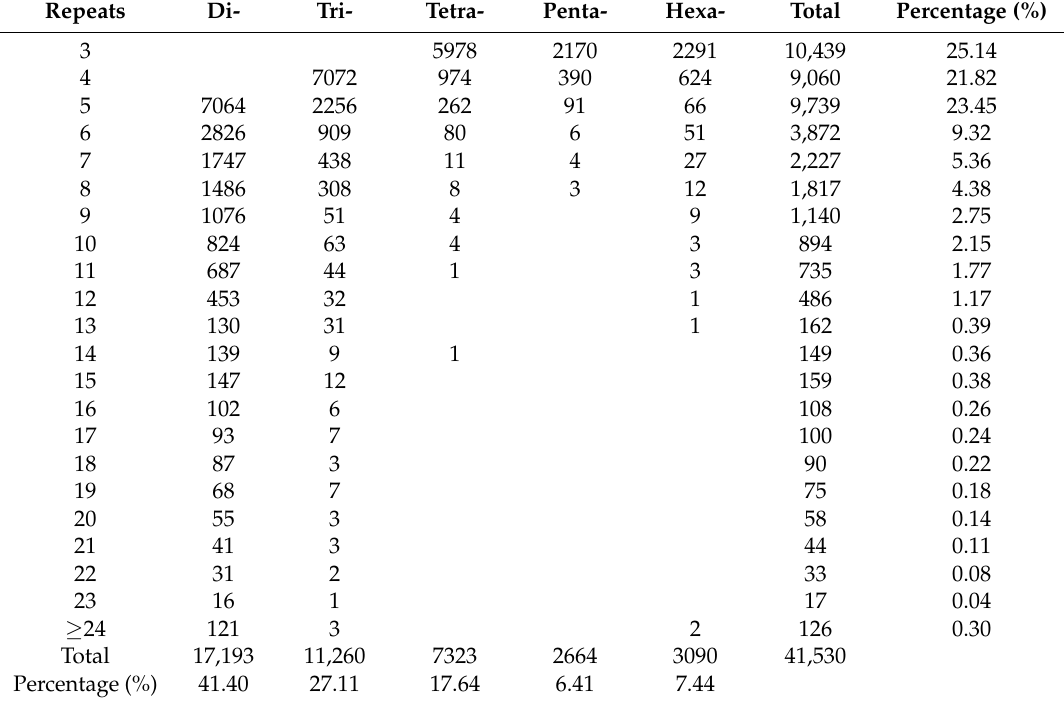
Table 2. Distribution of the different expressed sequence tag–simple sequence repeats (EST–SSRs) of Styrax